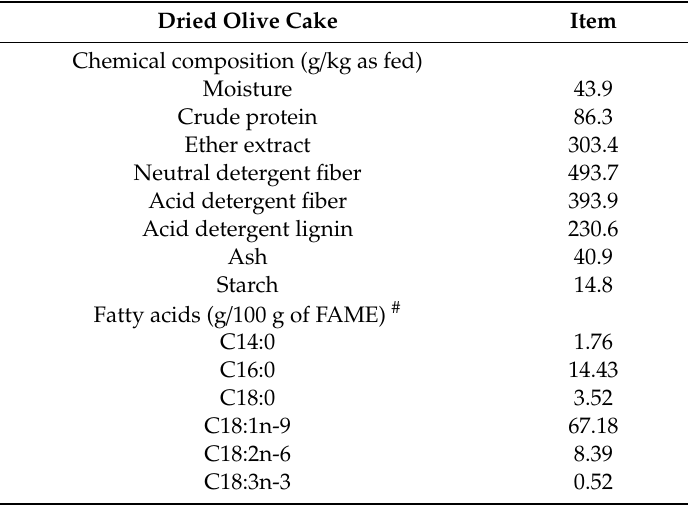
Table 3. Chemical and acidic composition of the dried olive cake used in the